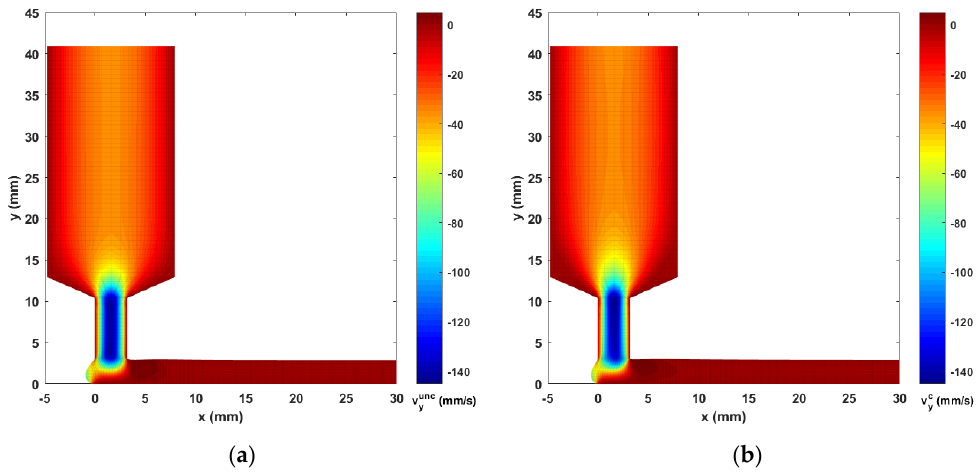
Figure 6. Velocity contours v y of ( a ) the uncoupled solution; ( b ) the fully coupled solution.